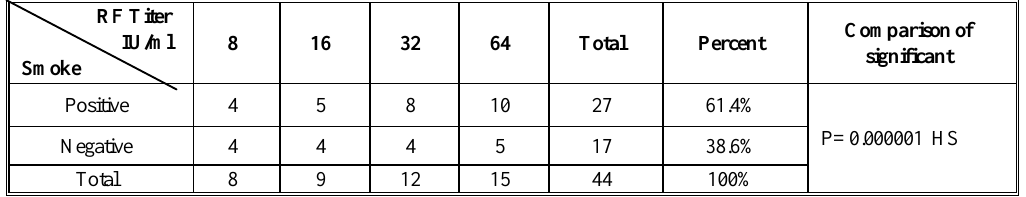
Comparison of significant